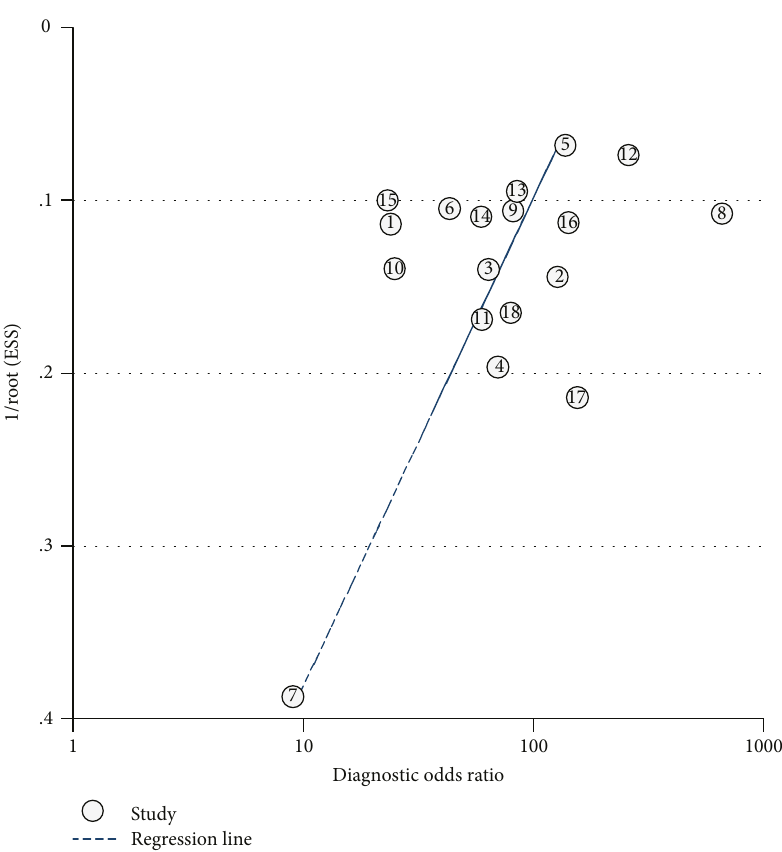
Figure 8: Deeks ’ funnel plot asymmetry test of the selected